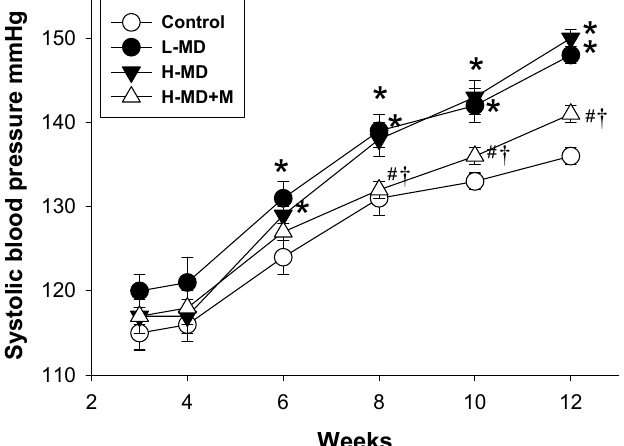
Figure 1. Effects of a maternal methyl-deficient diet (L-MD), high methyl-donor diet (H-MD), and high methyl-donor diet plus melatonin therapy (H-MD+M) on systolic blood pressure in male offspring. * p < 0.05 vs. control; # p < 0.05 vs. L-MD; † p < 0.05 vs. H-MD. n =